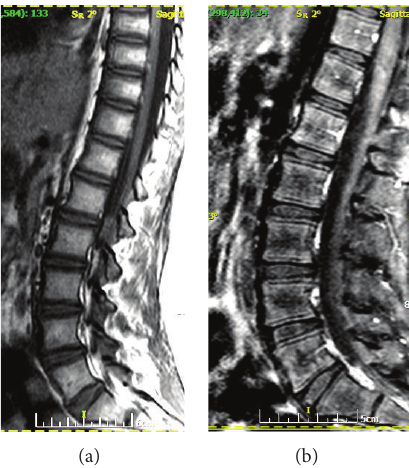
Figure 3: (a) A sagittal T1 SE image of the thoracolumbar spine showed mild hypointensity of the epiphyseal plates. (b) A sagittal T1 contrast- enhanced/fat-suppressed image demonstrated a double contour of vertebral bodies, with mild enhancement of the epiphyseal plates.